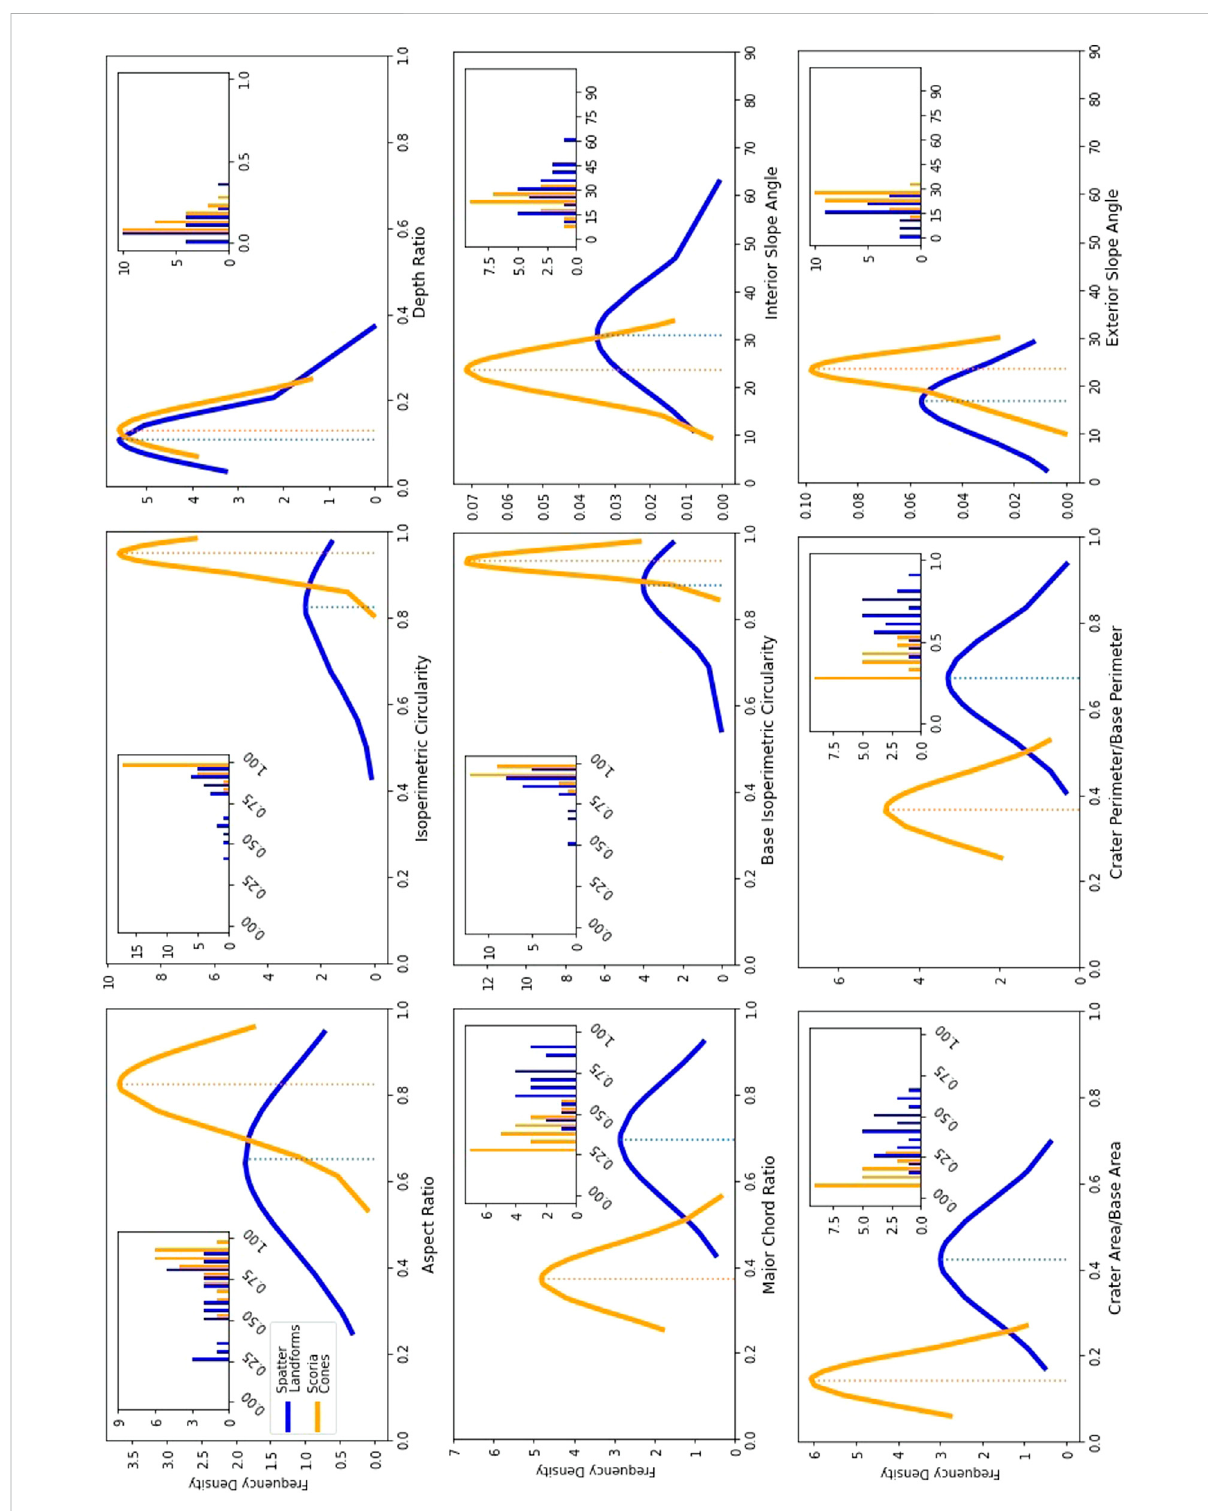
FIGURE 9 Frequency distribution of identi fi ed positive volcanic landforms parameters. The identi fi ed parameters for scoria cones all fall in a very distinct range. Spatter landforms have a wider variability of shapes. The cPer/bPer, cArea/bArea, and fl at-topped-ness of scoria cones represent a smaller vent relative to the base, while spatter landforms have a larger vent relative to the